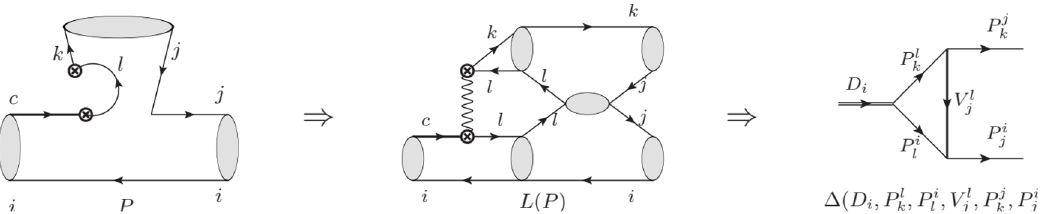
Figure 11 . Topological diagram ⇒ Topological-scattering diagram ⇒ Triangle diagram in T ⇒ P